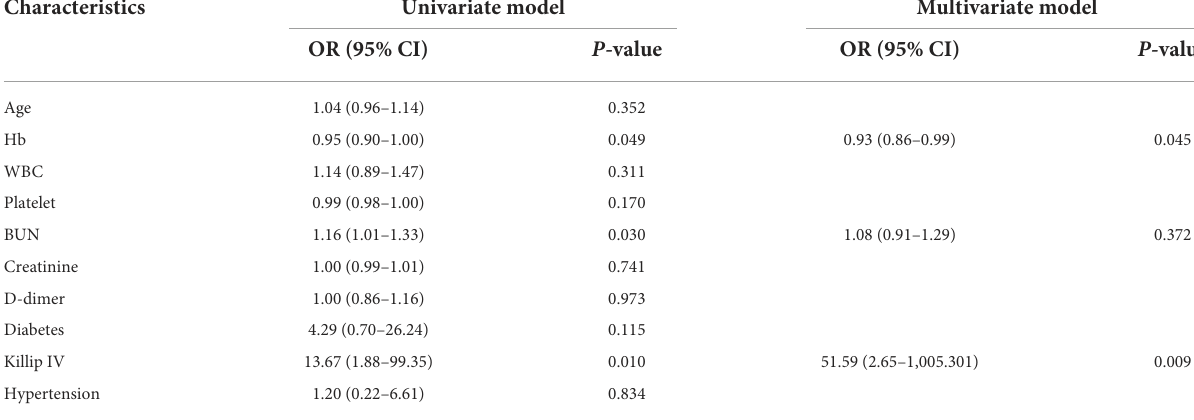
TABLE 4 Factors affecting in-hospital outcomes in AMI patients with in-hospital GIB.